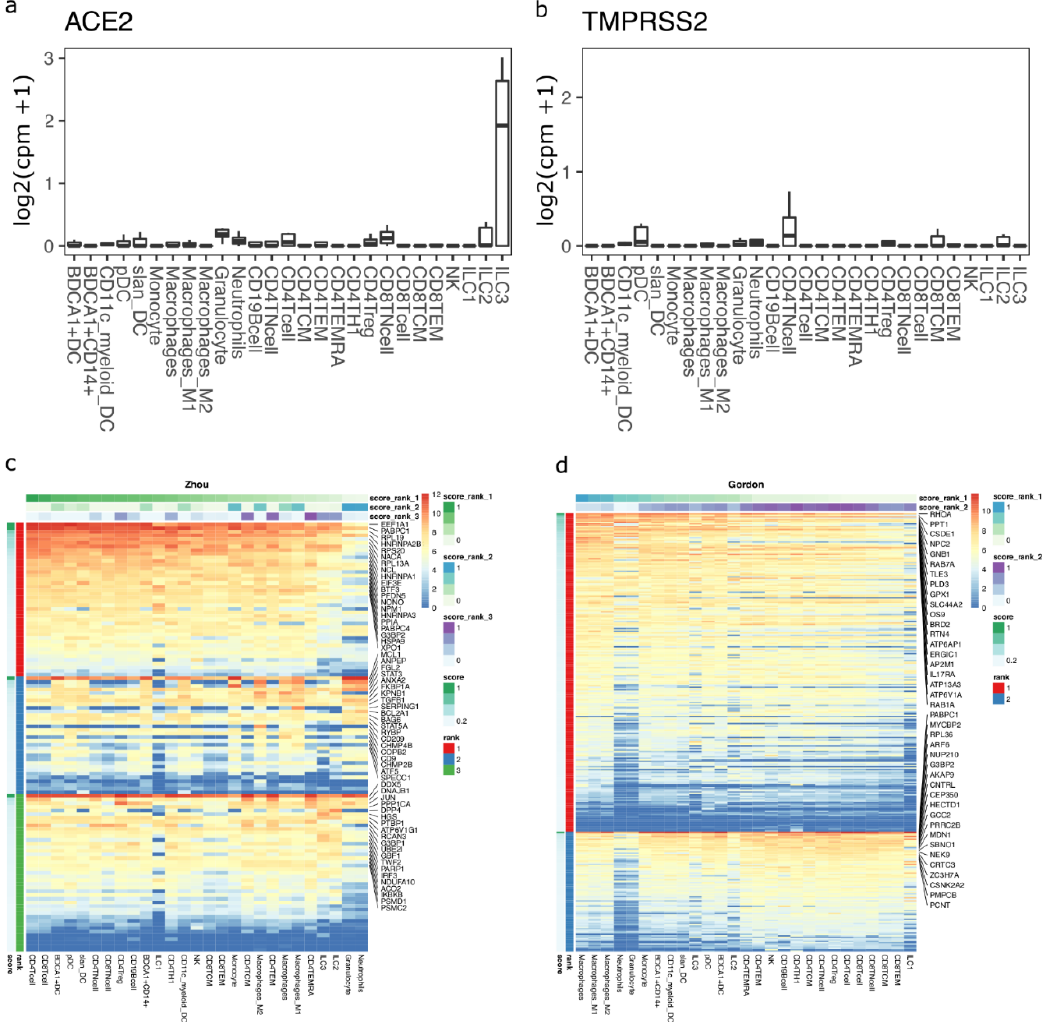
Figure 3. DIME enrichment of SARS-CoV-2 host factors in circulating immune cells. Expression of ( a ) ACE2 and ( b ) TMPRSS2 in circulating immune cells from the bulk dataset. Expression values are in log2(cpm + 1). DIME heatmap showing ranked enrichment of ( c ) Zhou, and ( d ) Gordon gene list in the circulating immune cells. The ranks depict the clusters as identified by DIME (see methods). Top 20 genes for each rank are shown. The cells are ordered based on the score of the rank 1 (top-weighted rank). Expression values are in log2(cpm + 1).